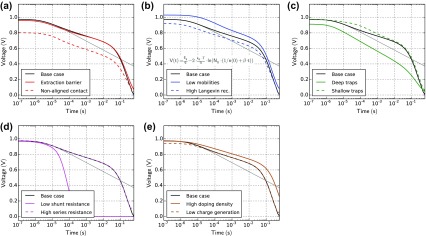
OCVD simulations for all cases in Table 1. The light is turned off at t = 0. The grey line indicates the analytic solution (Equation (11)) assuming homogeneous charge densities and purely bimolecular recombination.